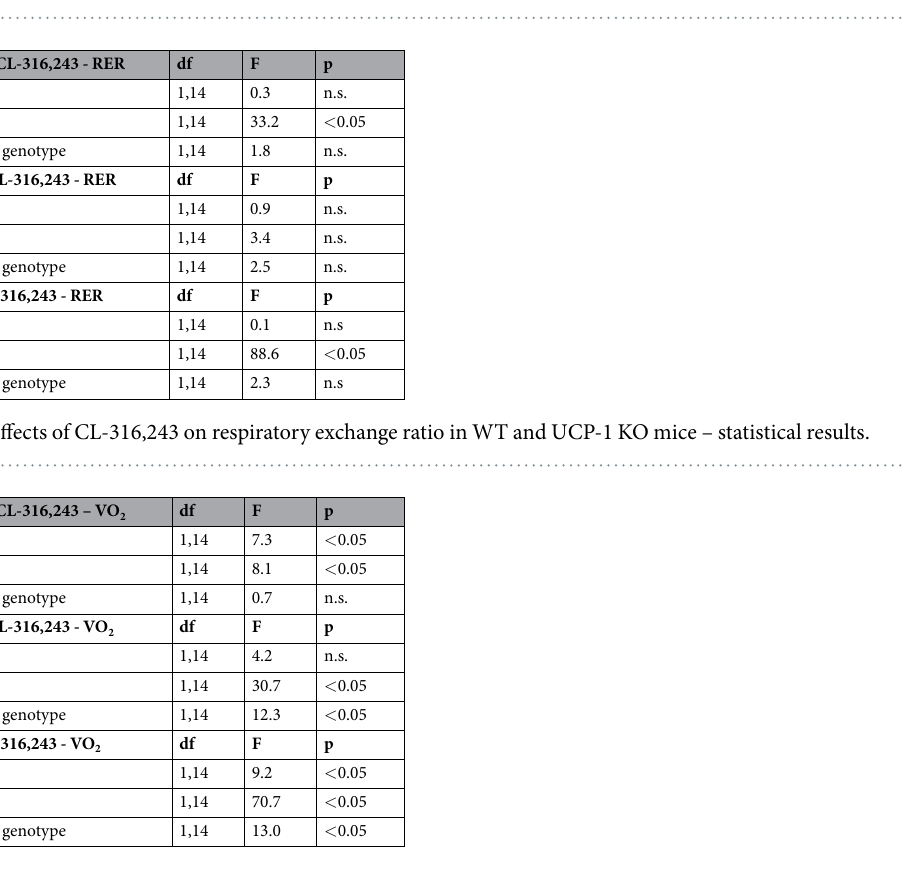
Table 6. Effects of CL-316,243 on heat production in WT and UCP-1 KO mice – statistical results.